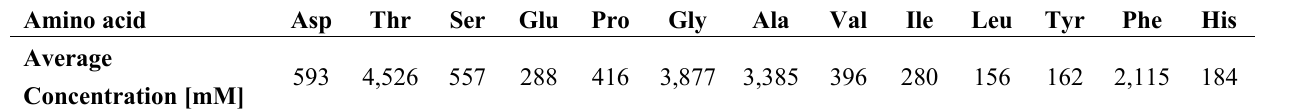
Table 1. Average concentrations of amino acids per one apricot cultivar (expressed as an average of all 239 apricot cultivars). Values are expressed in mmol·L − 1 . Amino acid Asp Thr Ser Glu Pro Gly Ala Val Ile Leu Tyr Phe His Average 593 4,526 557 288 416 3,877 3,385 396 280 156 162 2,115 184 Concentration [mM] n = 3; RSD =